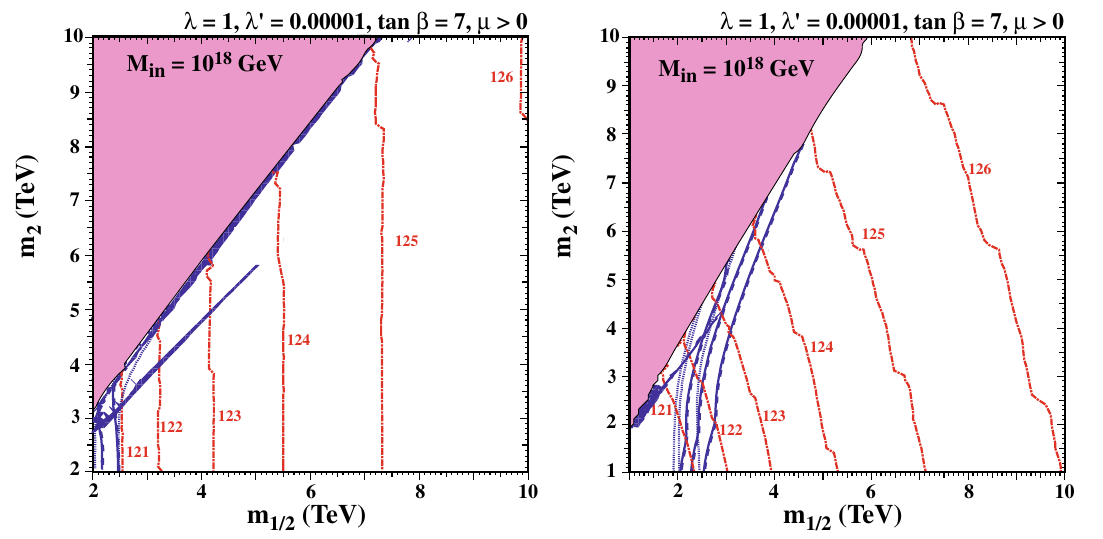
Fig. 10 Examples of ( m 1 / 2 , m 2 ) planes for Models M5 and M6 with M in = 10 18 GeV, λ = 1, and tan β = 7. We assume μ > 0 in both panels. As in Fig. 5, in the regions shaded pink there is no EWSB, and in the blue strips below these regions the relic density is in the range 0 . 06 < (cid:3) χ h 2 < 0 . 2. The red dot-dashed curves are Higgs mass con- tours, with the masses labelled in GeV. For each flavor choice, in the left panel there are two contours for the proton lifetime, τ